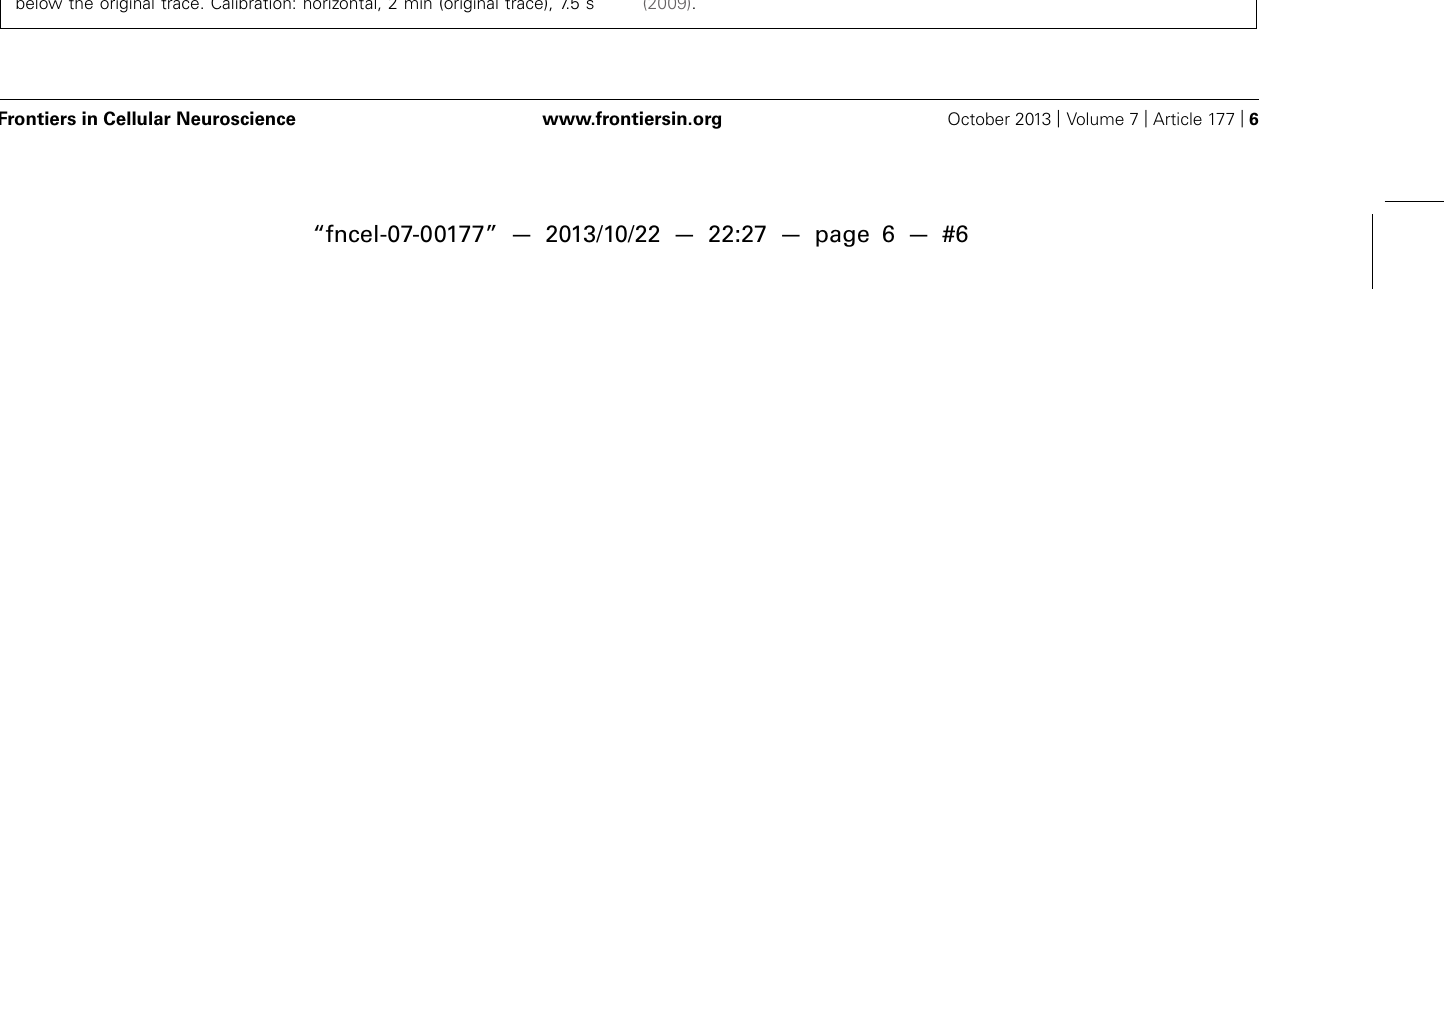
FIGURE 3 | Reduced spontaneous electrical activity in hippocampal slices of NKCC1 and AE3 knockout mice. (A) Representative extracellular recordings from the stratum pyramidale (CA3) of postnatal day 5 NKCC1 and AE3 WT and KO slices. The framed parts are shown as enlargements below the original trace. Calibration: horizontal, 2 min (original trace), 7.5 s